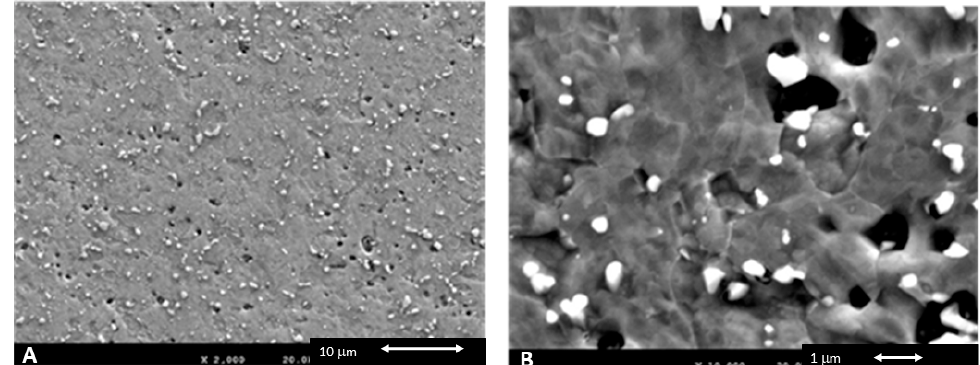
Figure 5. SEM micrograph of laser sintered sample with details of EDS-microanalysis of both the matrix and precipitates.